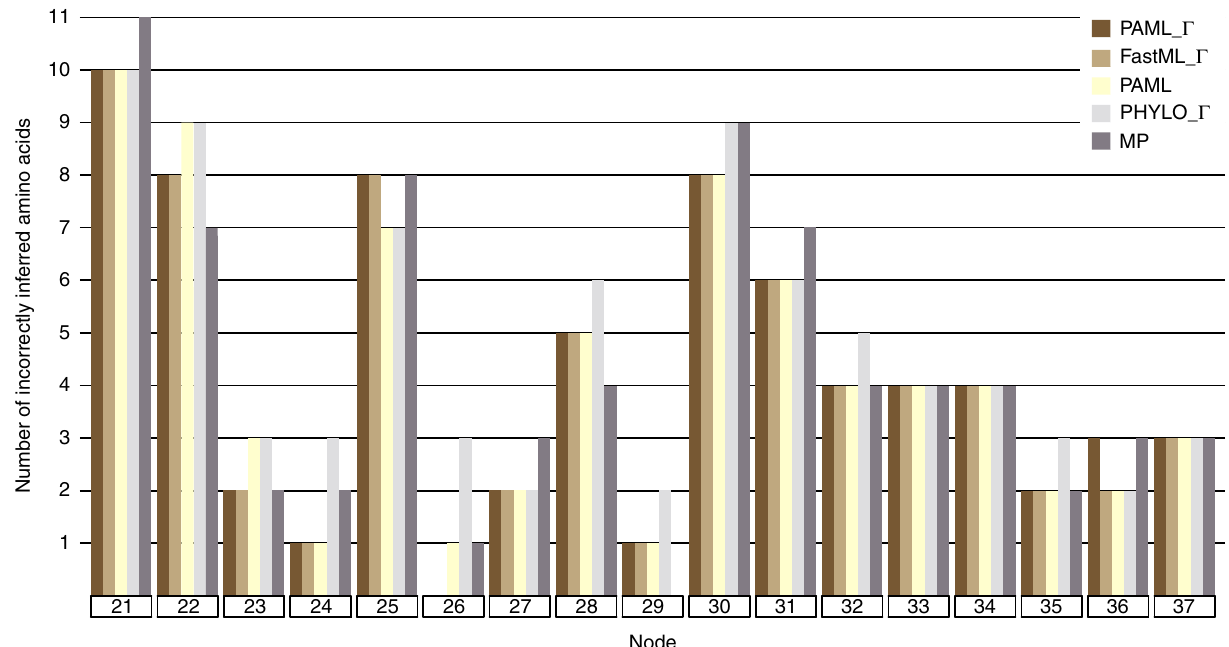
Figure 2 | Number of incorrectly inferred amino acid sites for each node of the phylogeny. The 19 leaf sequences from Fig. 1 were subjected to ASR analyses using Bayesian (PAML, FastML, PhyloBayes) with or without rate variation modelled as a gamma distribution ( ! ), as well as parsimony (MP). The inferred sequences were then compared to the true ancestral sequences from the 17 ancestral nodes in Fig. 1. Dark brown bars are PAML with a gamma distribution, light brown bars are FastML with a gamma distribution, yellow bars are PAML without gamma, light grey bars are PhyloBayes with a gamma distribution, and dark grey bars are maximum parsimony. Colour code is irrespective of FP colour emission